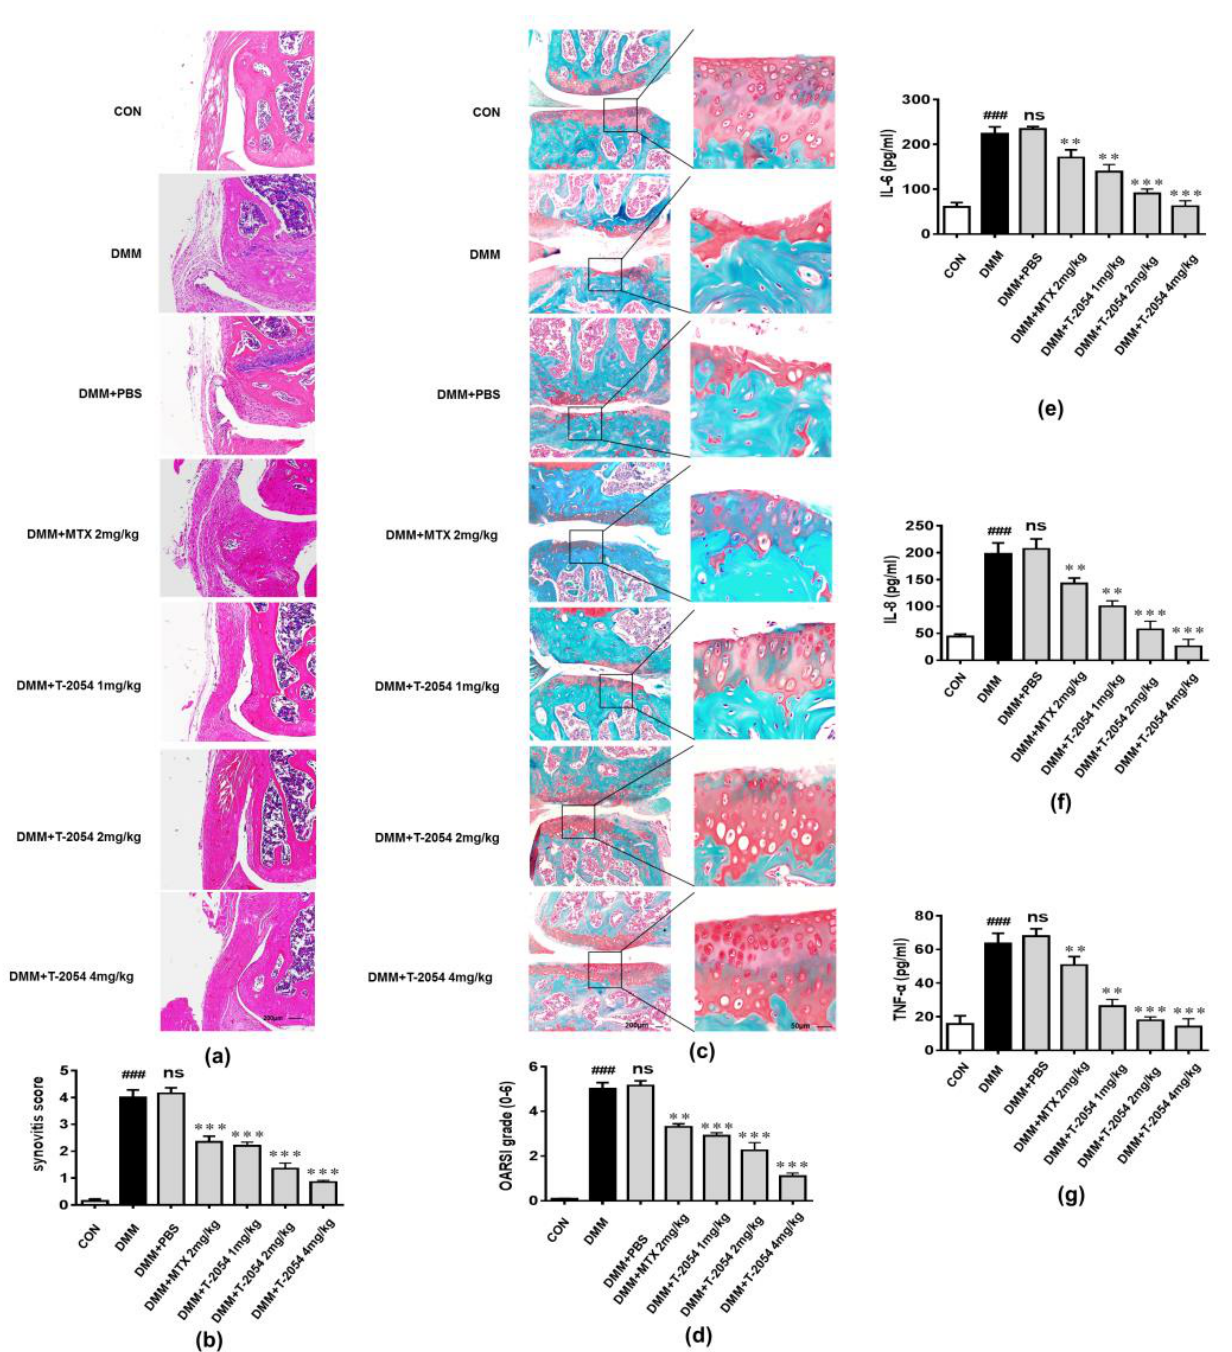
Figure 7. Detected cartilage damage of knee joints. C57BL/6 mice were administered intraperitoneally with PBS, methotrexate (MTX) or T-2054 for 10 weeks after surgery. Representative histopathology of the knee joints from the CON group, destabilization of the medial meniscus (DMM) group, DMM + PBS group, DMM + methotrexate (MTX) (2 mg/kg) group or DMM + T-2054 (1, 2, 4 mg/kg) group were stained with hematoxylin and eosin (H&E) and Safranin O fast green staining (SO) ( a , c ). The Osteoarthritis Research Society International (OARSI) scores of each group were presented ( b ). The histopathological scores of each group were assessed to evaluate the infiltration of inflammatory cells and the degree of joint destruction ( b , d ). Cytokines production of IL-6 ( e ), IL-8 ( f ) and TNF-α ( g ) was tested in serum by ELISA at the end of the experiment. Each value represents the mean ± SD of 8 mice per group, performed in 2 different experiments. Magnification = 200; bar: 50 μm. ### p < 0.001 vs. CON; ns, ** p < 0.01 and *** p < 0.001 vs. DMM.